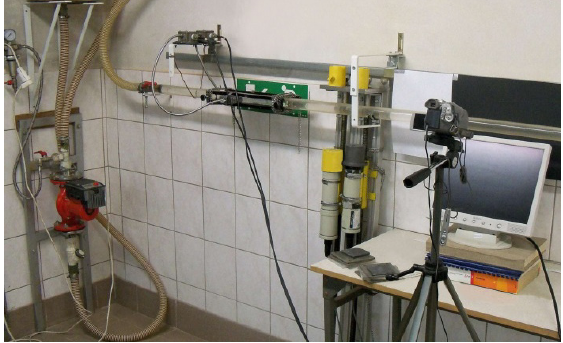
Fig. 2. General view of the experimental set-up.